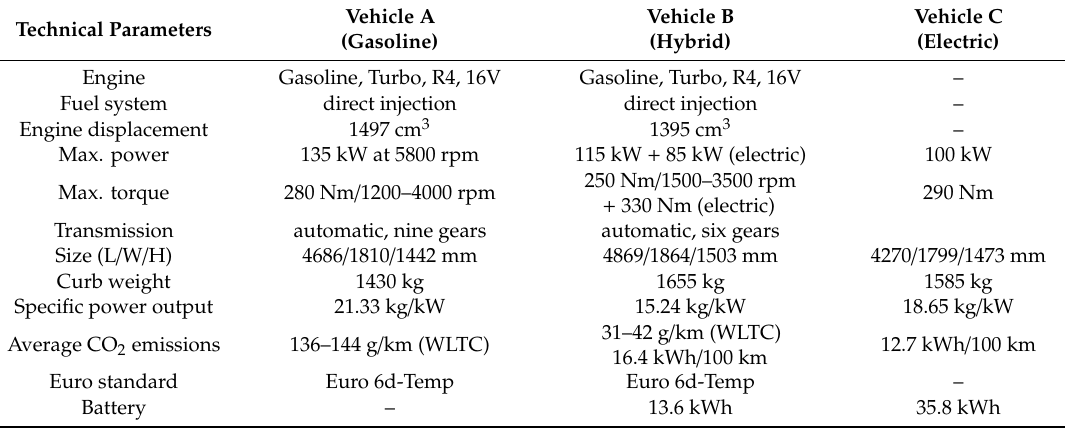
Table 1. Technical parameters of the tested